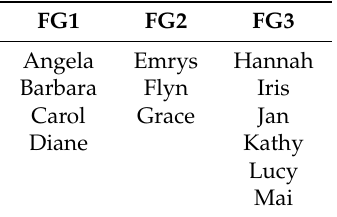
Table 1. The staff focus groups